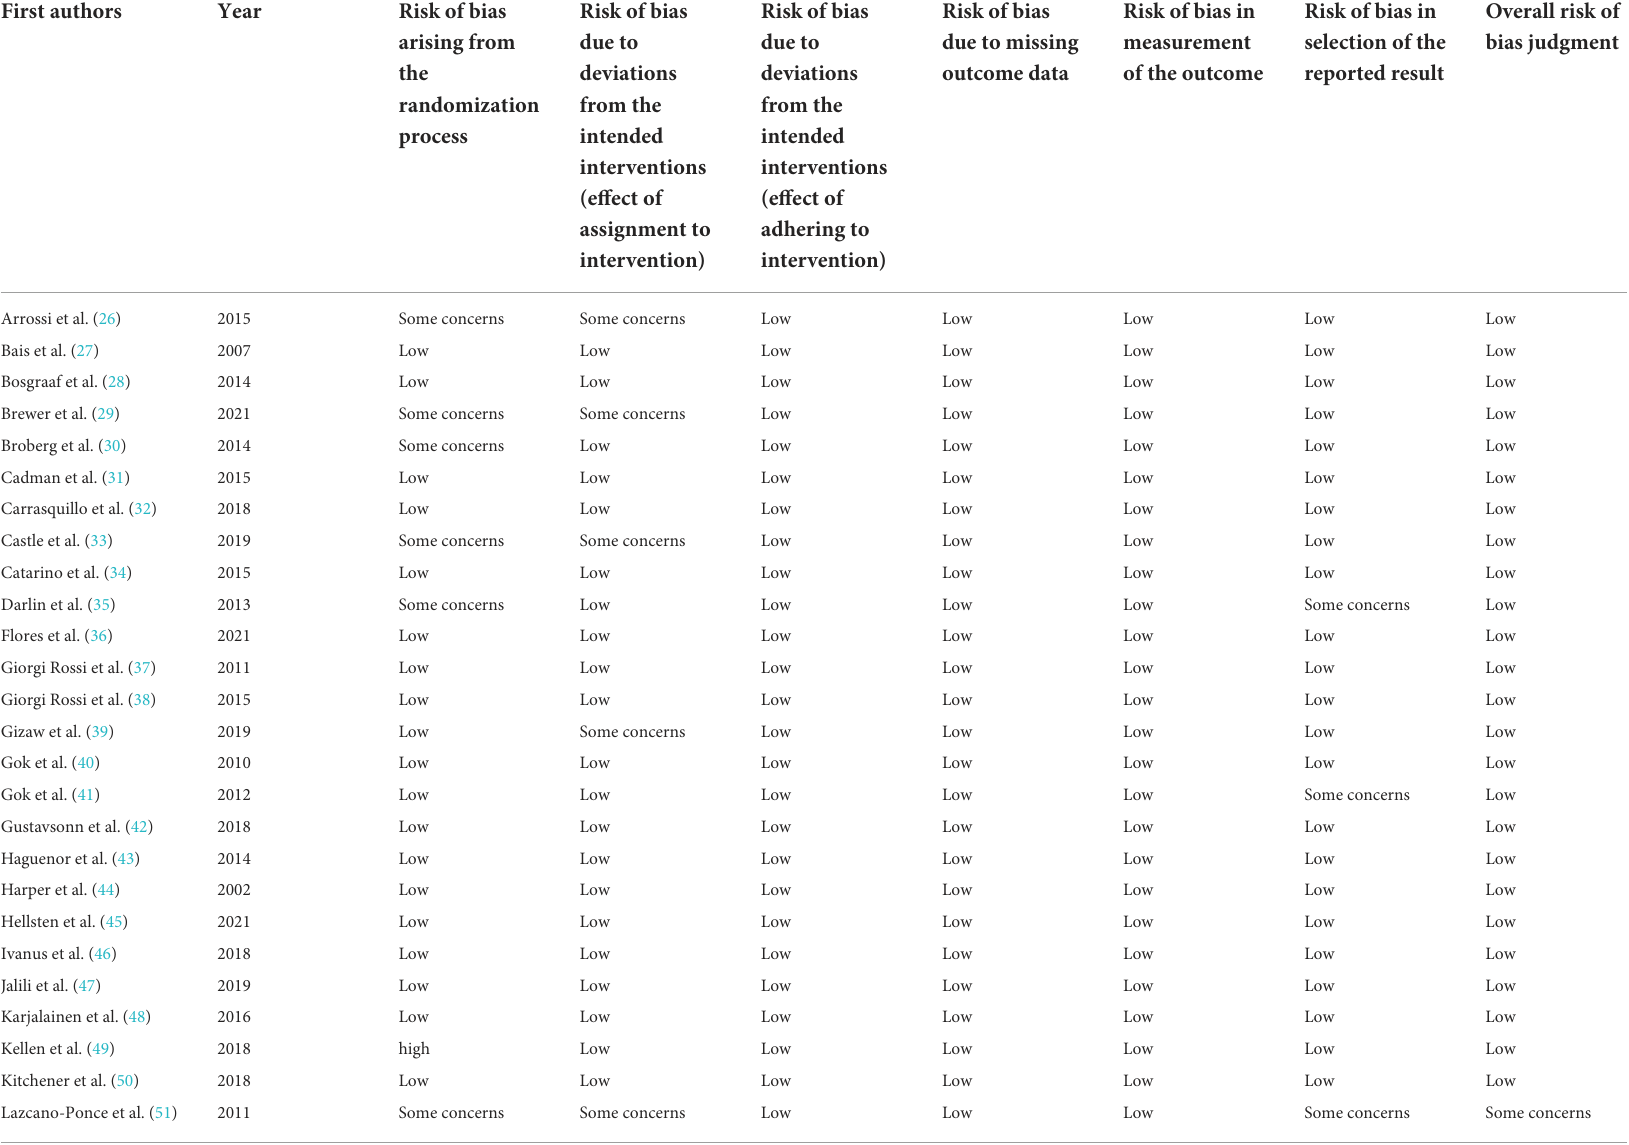
TABLE 1 Risk of bias of included RCTs assessed by Cochrane risk of bias